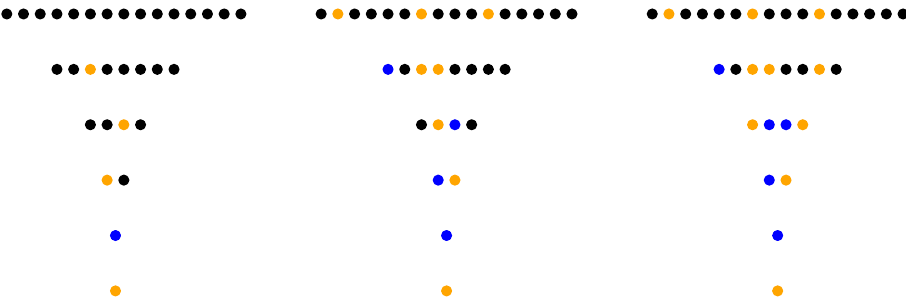
Figure 5. The five rules completing the binary tree row by row in our first Python implementation of the Golden Automaton (“GAI”)